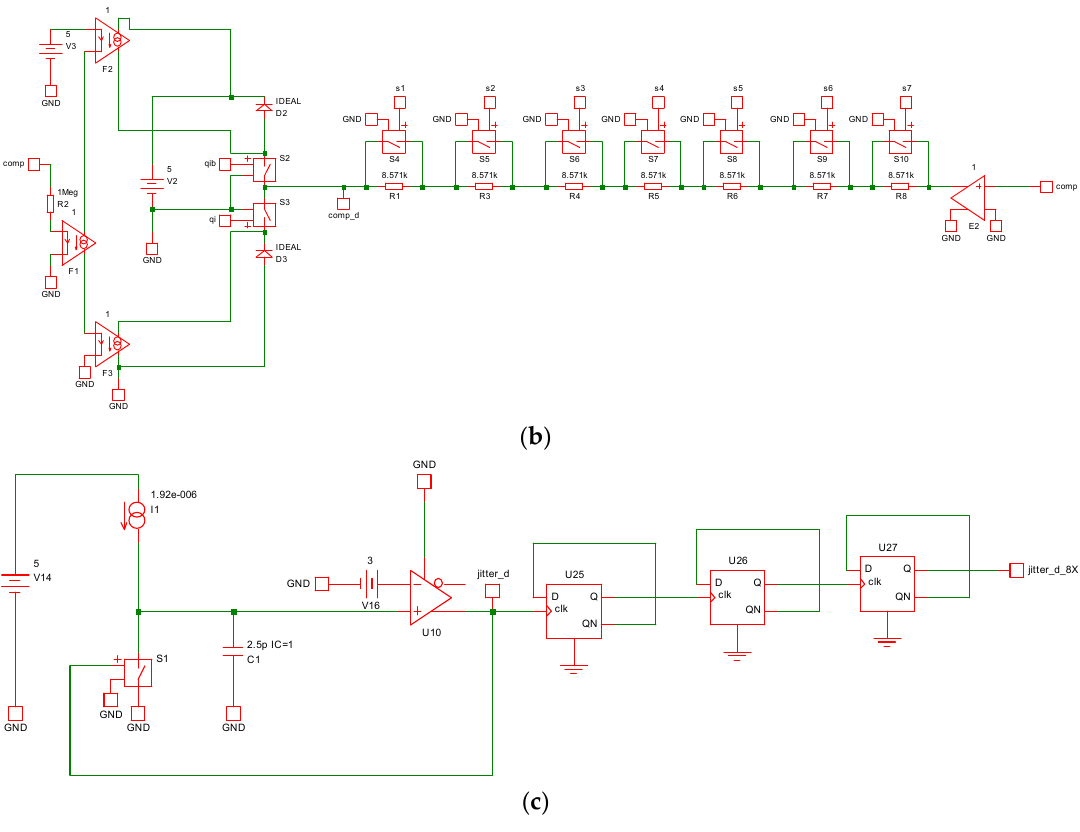
Figure 16. The novel frequency swapping circuit: ( a ) binary code for frequency swapping; ( b ) ratio for frequency swapping; and ( c ) frequency swapping modulation.